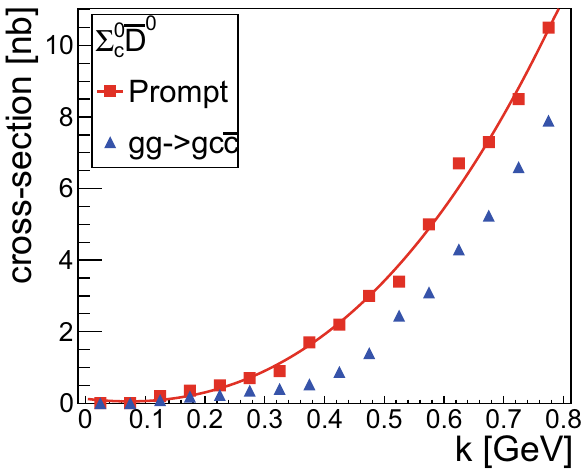
Fig. 2 Thecrosssectionoftheinclusive (cid:2) 0 c ¯ D 0 pairproductioninterms of their relative momentum at the center-of-mass energy Theredboxpointsareobtainedbyallthepartonleveldiagramsswitched on. The blue triangle points are those for only the gg → gc ¯ c switched on. The red sold curve is an interpolation. The case for other (cid:2) channel is the same, i.e. the gg → gc ¯ c parton process is the